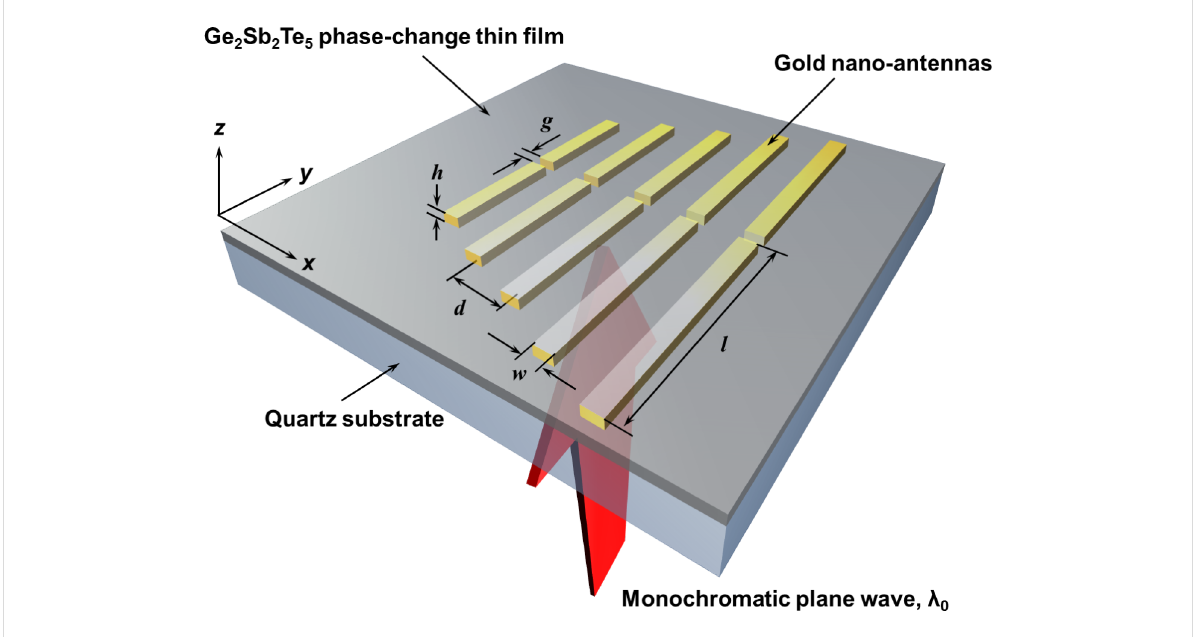
Figure 1: Schematic diagram of a near-field energy controllable template. With a monochromatic plane wave illumination on a nano-antenna system, the near-field intensity distributions can be selectively excited on constituent dipole nano-antennas by controlling different intermediate phases of an underneath phase-change thin film (Ge 2 Sb 2 Te 5 , GST). The hybrid plasmonic system of gold nano-antennas and phase-change materials can be fabricated on a transparent quartz substrate. The length of the antenna l ranges from 120 to 218 nm, while the centre-to-centre distance d